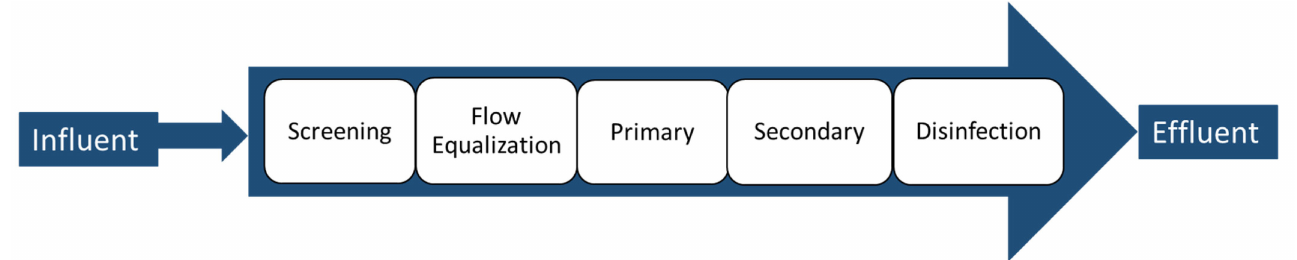
Figure 1. Common treatment train for slaughterhouse wastewater